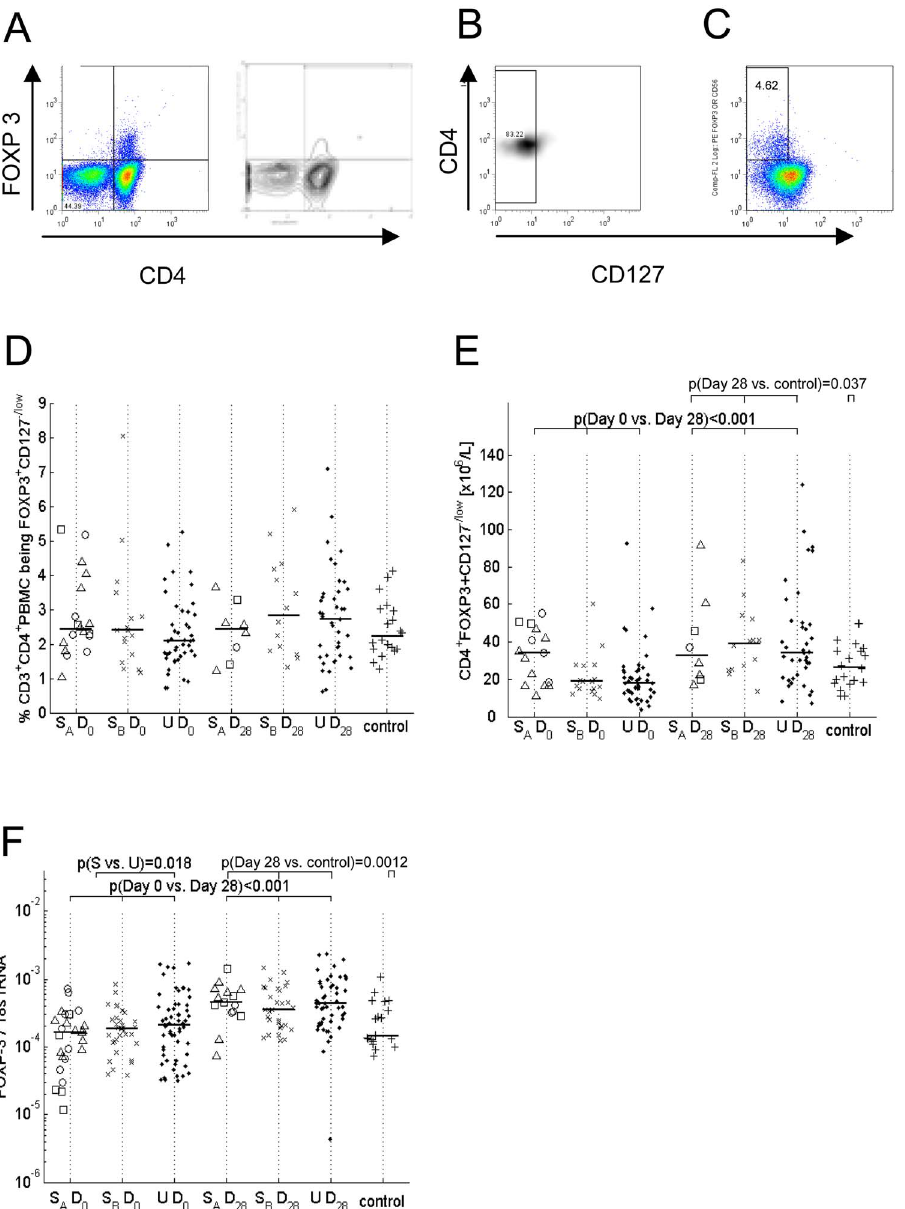
Figure 1. Similar number and proportion of Tregs in uncomplicated and severe disease, increasing during convalescence. Tregs were defined as CD3 + CD4 + PBMC being FOXP3 + and CD127 2 /low . (A) CD3 + viable PBMC were displayed according to CD4 and FOXP3 and FOXP3 positive cells were defined on contour display as cells above the 90% contour level. (B) CD3 + CD4 + FOXP3 + PBMC were displayed according to CD127 expression to define the CD127 low cut off. (C) both gates were applied to CD3 + CD4 + PBMC. (D) The percentage of Tregs for severe cases is shown for the subgroup (S A ) comprising cases with CM (triangles), SA (squares) and SRD (circles), for the subgroup with severe prostration (S B ), and for uncomplicated cases (U) for days 0 (D0) and 28 (D28) and compared to healthy controls of a similar age range recruited from the study area at the same time. (E) absolute numbers of cells expressing a Treg phenotype. (F) FOXP3 mRNA levels expressed as a ratio to the house keeping gene 18s rRNA. Dots represent individual data; bars represent the median. P-values are derived from the random effects linear regression model, adjusting for age, sex, duration of symptoms and numbers of clones isolated.